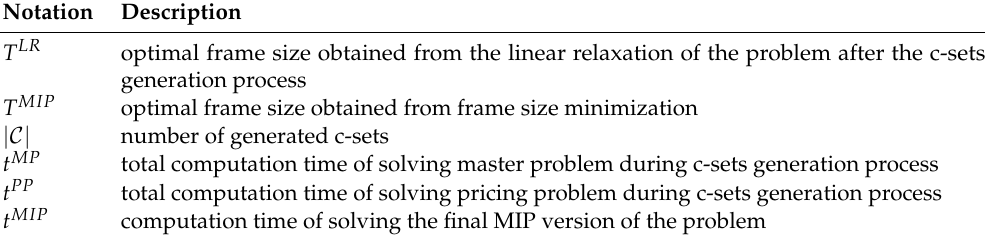
Table 5. Numerical results—explanation.